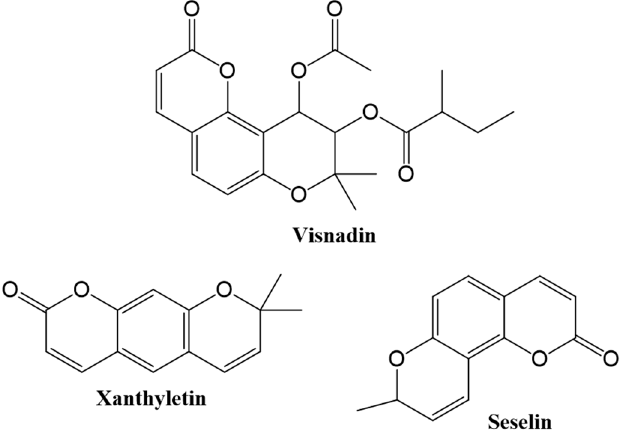
Figure 3. Chemical structures of some pyranocoumarins.